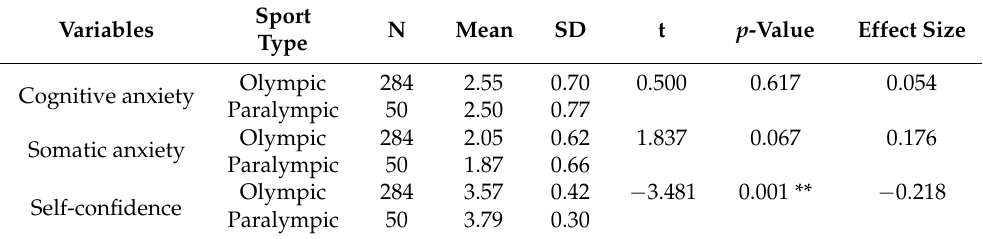
Table 6. Differences between Olympic and Paralympic sports.